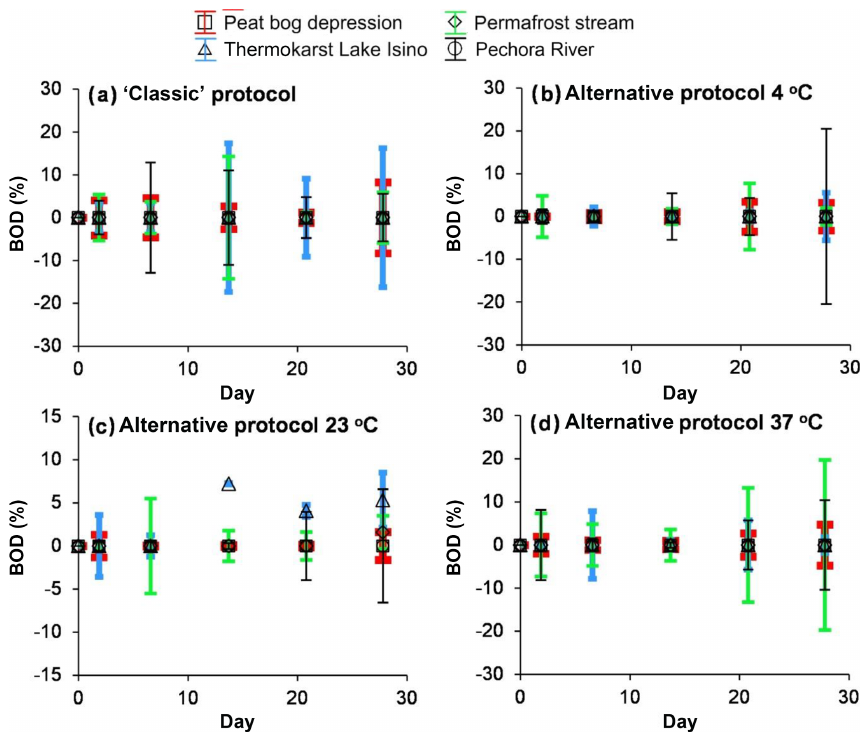
Figure 2. Percentage of biodegradable DOC as a function of time. (a) The classic protocol of 0.7µm GF/F filtration at 23 ◦ C; (b–d) the alternative protocol of 3µm filtered solution incubated at 4 ◦ C (b) , 23 ◦ C (c) and 37 ◦ C (d) and filtered through 0.22µm at each sampling. The error bars are ± 1SD of the triplicates or, in a few cases,